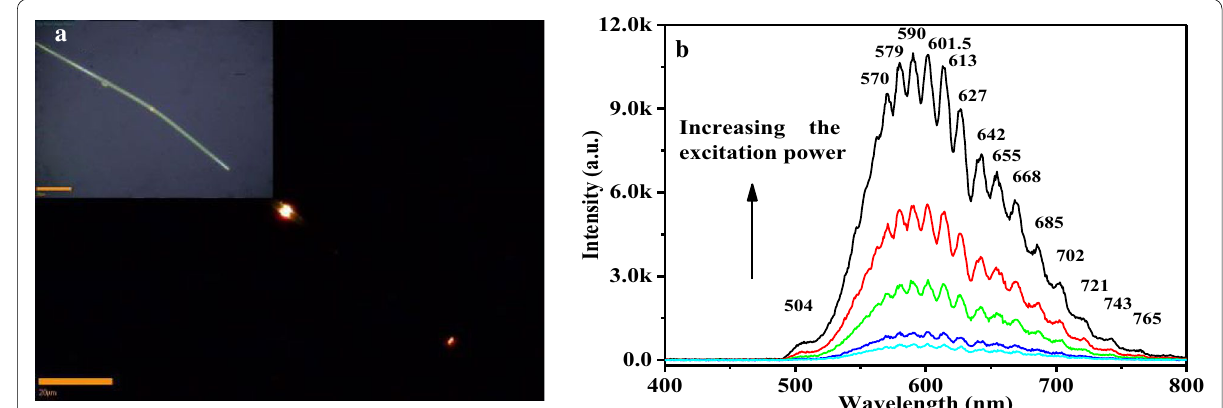
Fig. 5 a Far-field emission image of single Sn(IV) heavy slightly doped CdS nanowire. Inset is optical morphology image. Scale bars are 20 μm. b The corresponding far-field PL spectra under increasing excitation